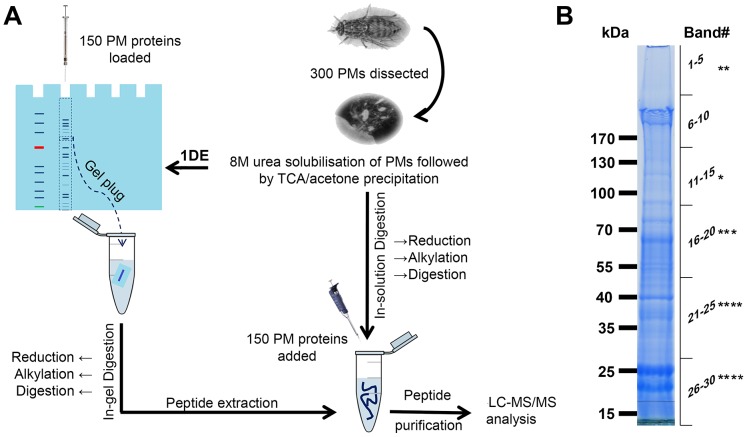
Experimental flow diagram.A total of 300 PMs were dissected and split equally into 2 tubes for urea/SDS solublisation and acetone precipitation. (A) One batch of PMs were sent directly for in-solution trypsin digestion whilst the other were fractionated on a 4–20% gradient gel. (B) 30 bands were cored from the gel from top to bottom and each gel plug was processed for in-gel trypsination mass spectrometry analysis. The position and number of asterisks indicate the regions of the gel where GmmPer66 was identified.